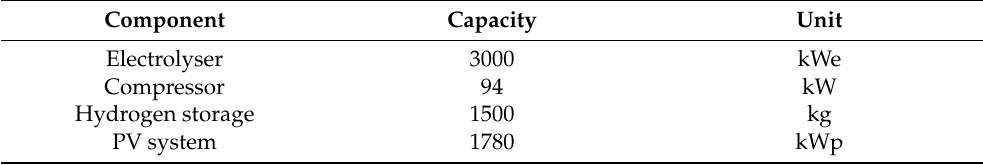
Table 4. Preliminary case related capacity values for P 1 = P 2 = 0.07 €